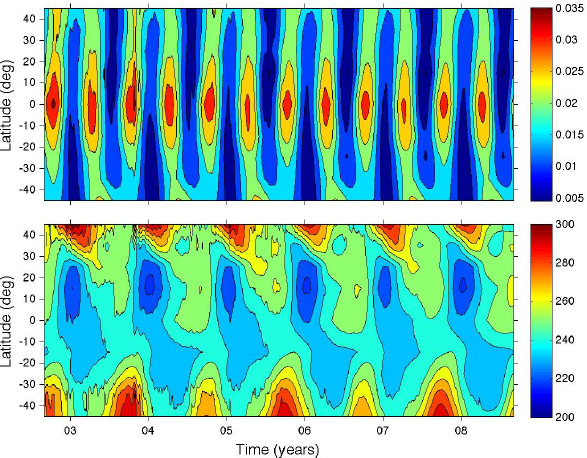
Fig. 13. Fitting components as a function of altitude in three latitude belts in the MLT. All amplitudes have been given as a ratio between the original amplitude in Eq. (2) and the the constant term c(z) in Eq. (2) and given in %. Line identifications: Annual ( a 1 and b 1 ): solid and dashed red, respectively. Semi-annual ( a 2 and b 2 ): solid and dashed blue, respectively, solar ( s ): solid magenta. The QBO values are not shown. The zero value line has been shown by a thin black line. Left: 50 ◦ S–40 ◦ S, Middle: 10 ◦ S–10 ◦ N, Right: 40 ◦ N– 50 ◦ N.